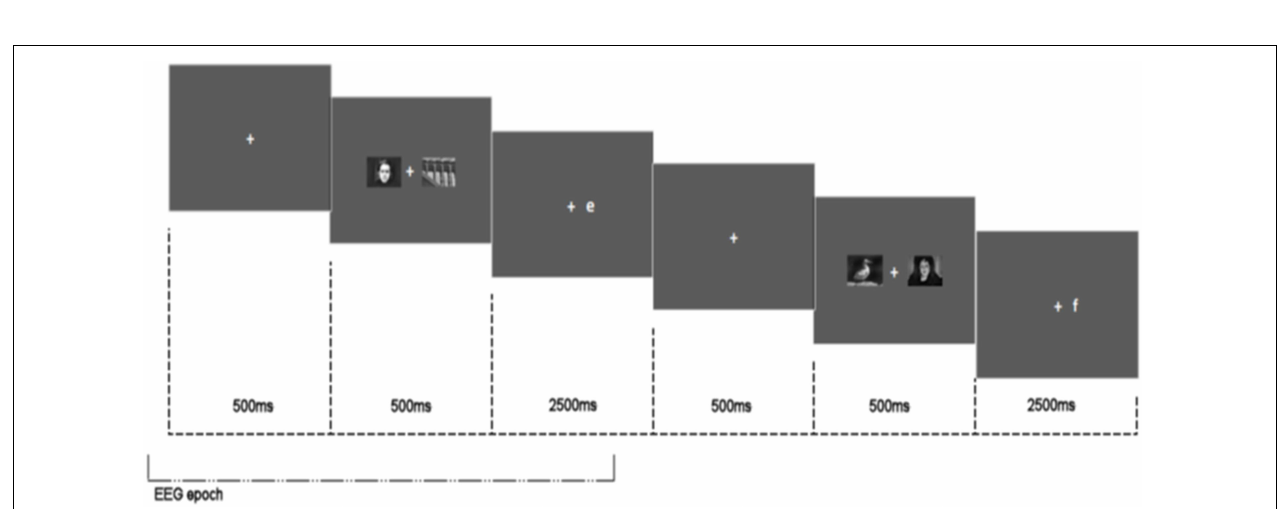
FIGURE 1 | Attention switching task stimulus configuration [adapted with permission from Wylie et al. (7)] showing seven consecutive trials/EEG epochs.